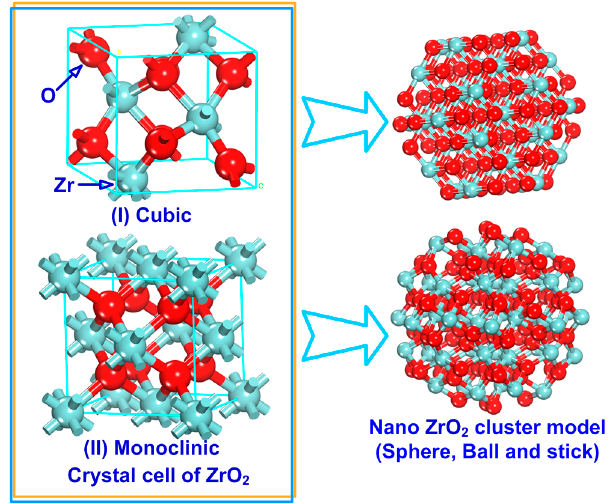
Figure 11. The molecular model of nano-ZrO 2 .